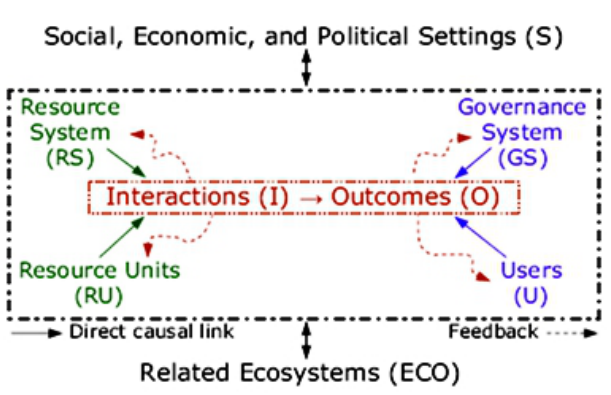
Fig. 1 . The main components of the social-ecological system (SES) framework (Source: Ostrom